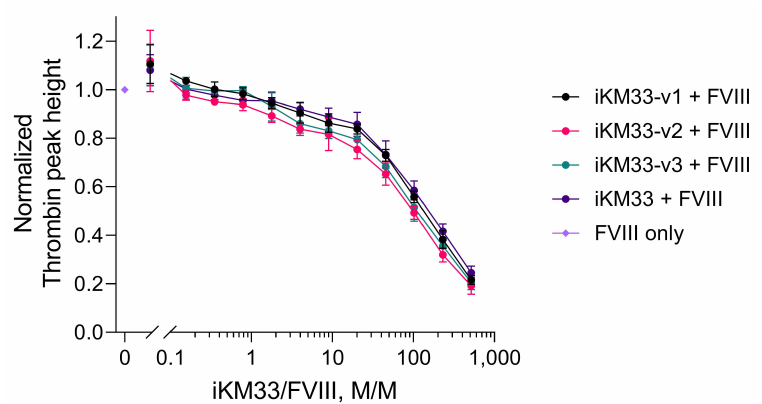
Figure 5. Effects of scFv iKM33 variants on FVIII activity in TG assay. Serially diluted iKM33 variants (60 nM to 0.008 nM) were incubated for 15 min at room temperature with 116 pM FVIII and tested in TG assay. The results are normalized to the control sample (no iKM33). Mean ± SD, n = 3. Statistical analysis: two-way ANOVA, Tukey’s multiple comparisons test for each dilution, no significant difference, p > 0.05.